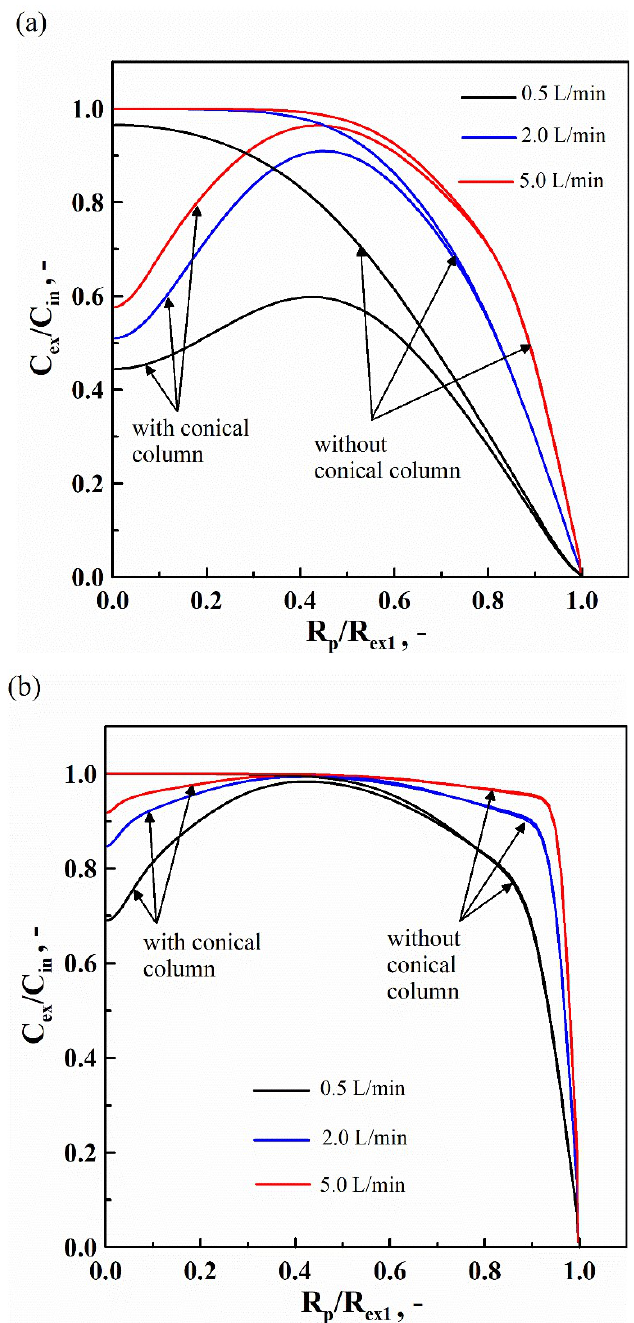
Figure 10. Effect of conical column on the exit concentration profile of the hollow tapered cylinder for the particle diameters of ( a ) 3 nm and ( b ) 10 nm at different flow rates.